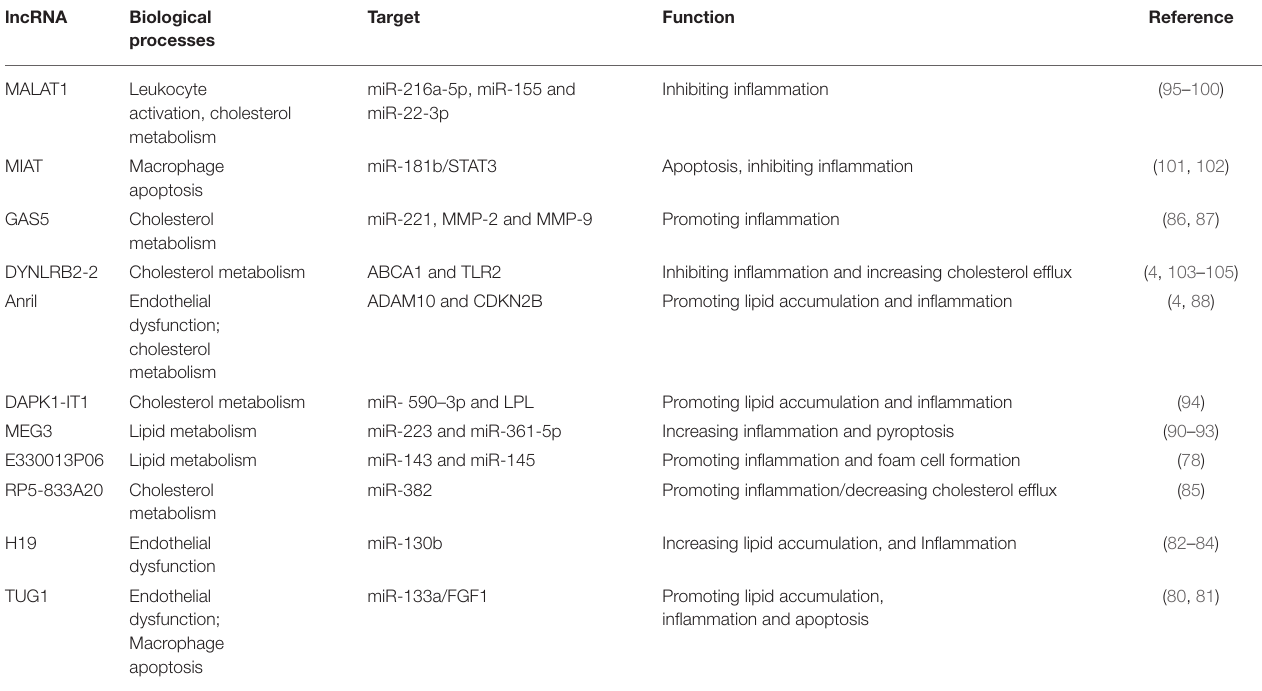
TABLE 1 | A list of lncRNAs involved in lipid accumulation and